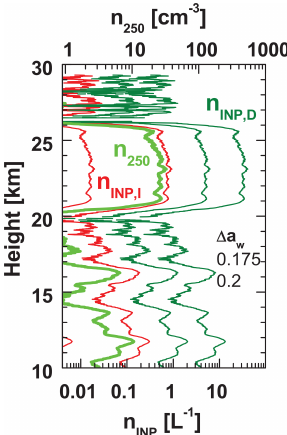
Figure 13. Retrieval results for 29 January 2020 in terms of INP concentrations n INP , I and n INP , D and large particle number concen- tration n 250 (considering particles with radius > 250nm). See text for more details of the INP computations in the case of immersion freezing (red profiles) and deposition nucleation (olive profiles). We consider leonardite as the organic aerosol substance (see Table 2). The INP concentrations are estimated by assuming an air parcel lift- ing period of 600s (period of supersaturation with (cid:49)a w of 0.175 (low INP numbers) and 0.2 (high INP values)) and ice nucleation temperature of − 50 ◦